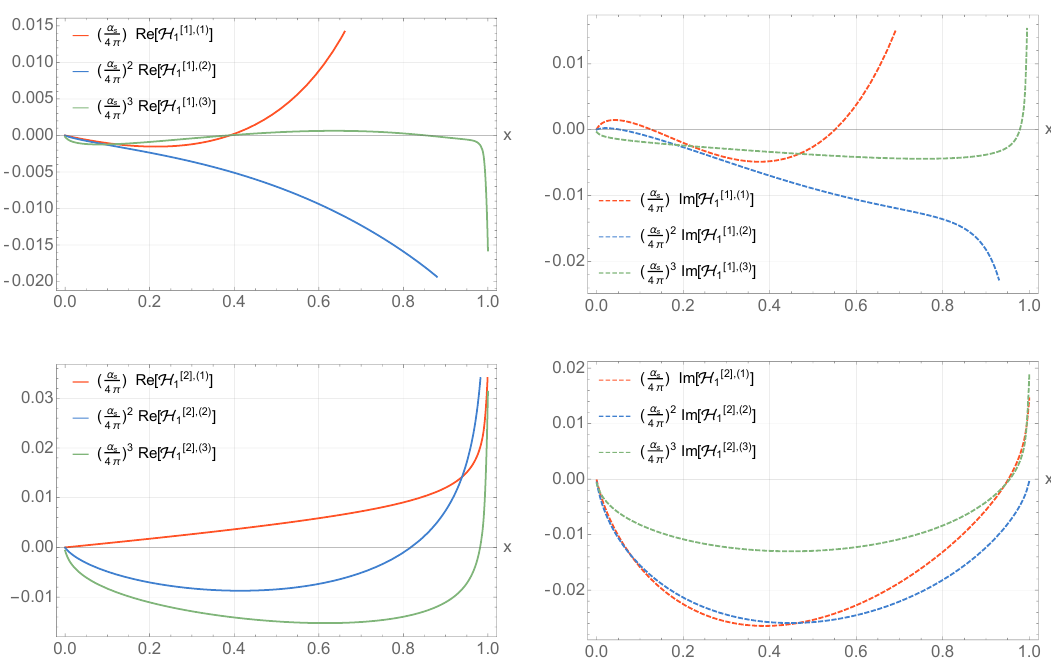
relevant for helicities 1 , fin